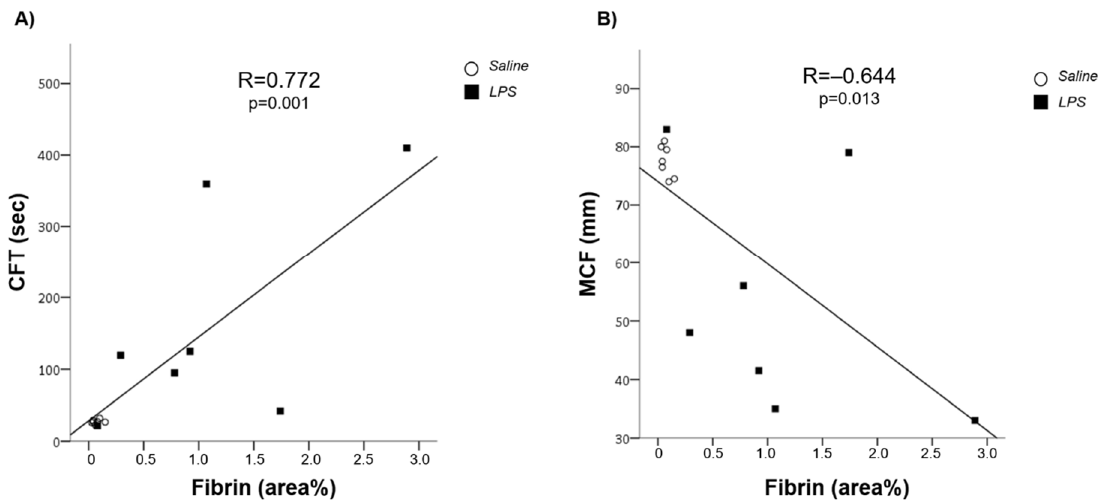
Figure 7. Correlation between fibrin clot formation time ( A ) and maximum clot firmness ( B ).